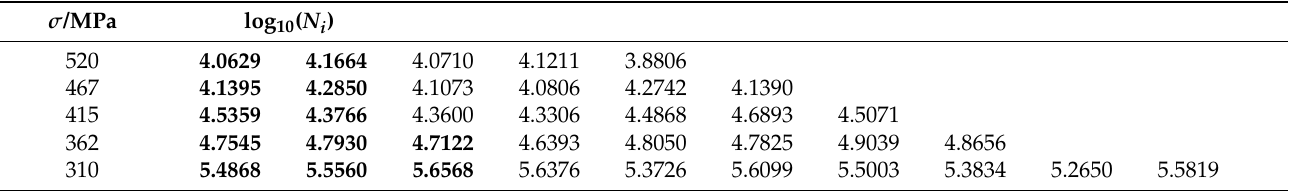
Table 4. Simulated test results of two methods.